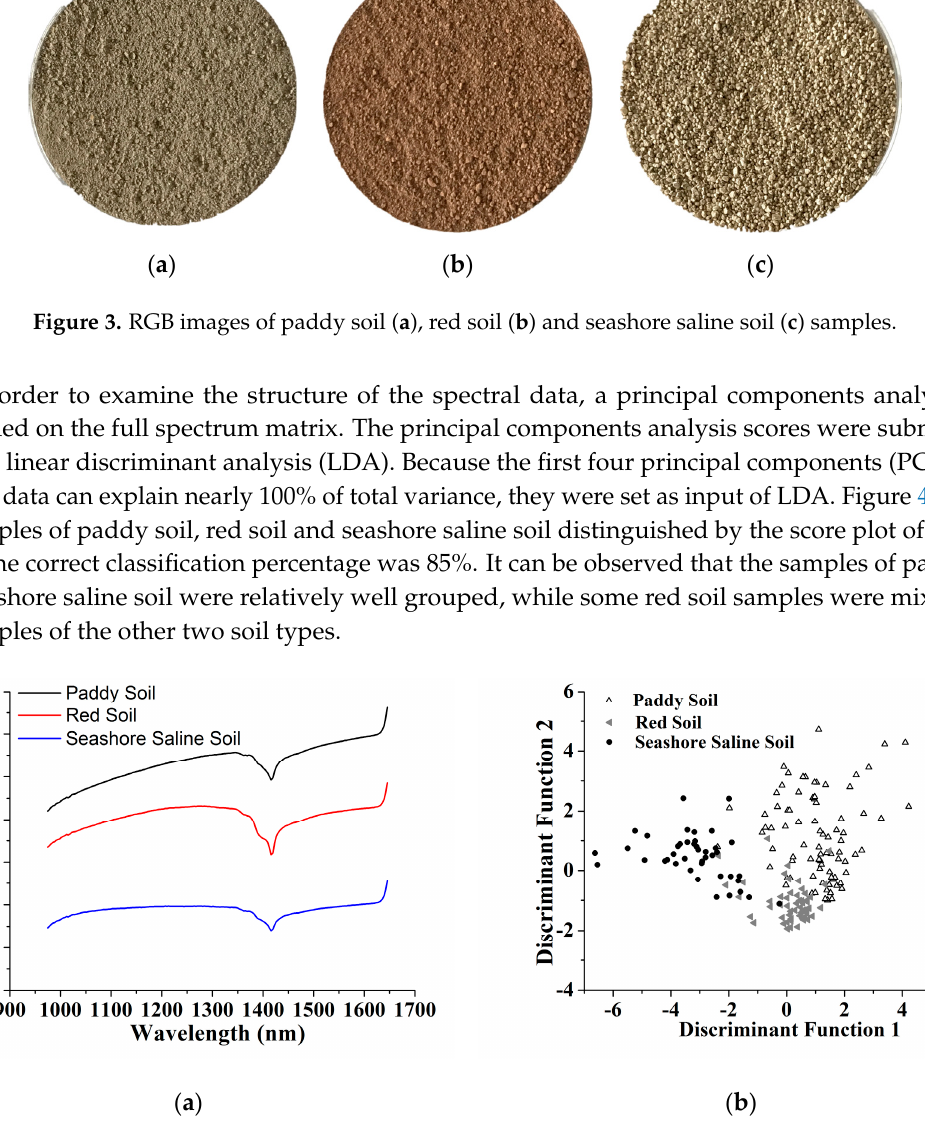
Figure 4. ( a ) The average spectrum of each soil type in the wavelength range of 975–1645 nm; ( b ) Grouping of 183 soil samples based on Fisher’s LDA using the first four principal components of full spectrum matrix as input.